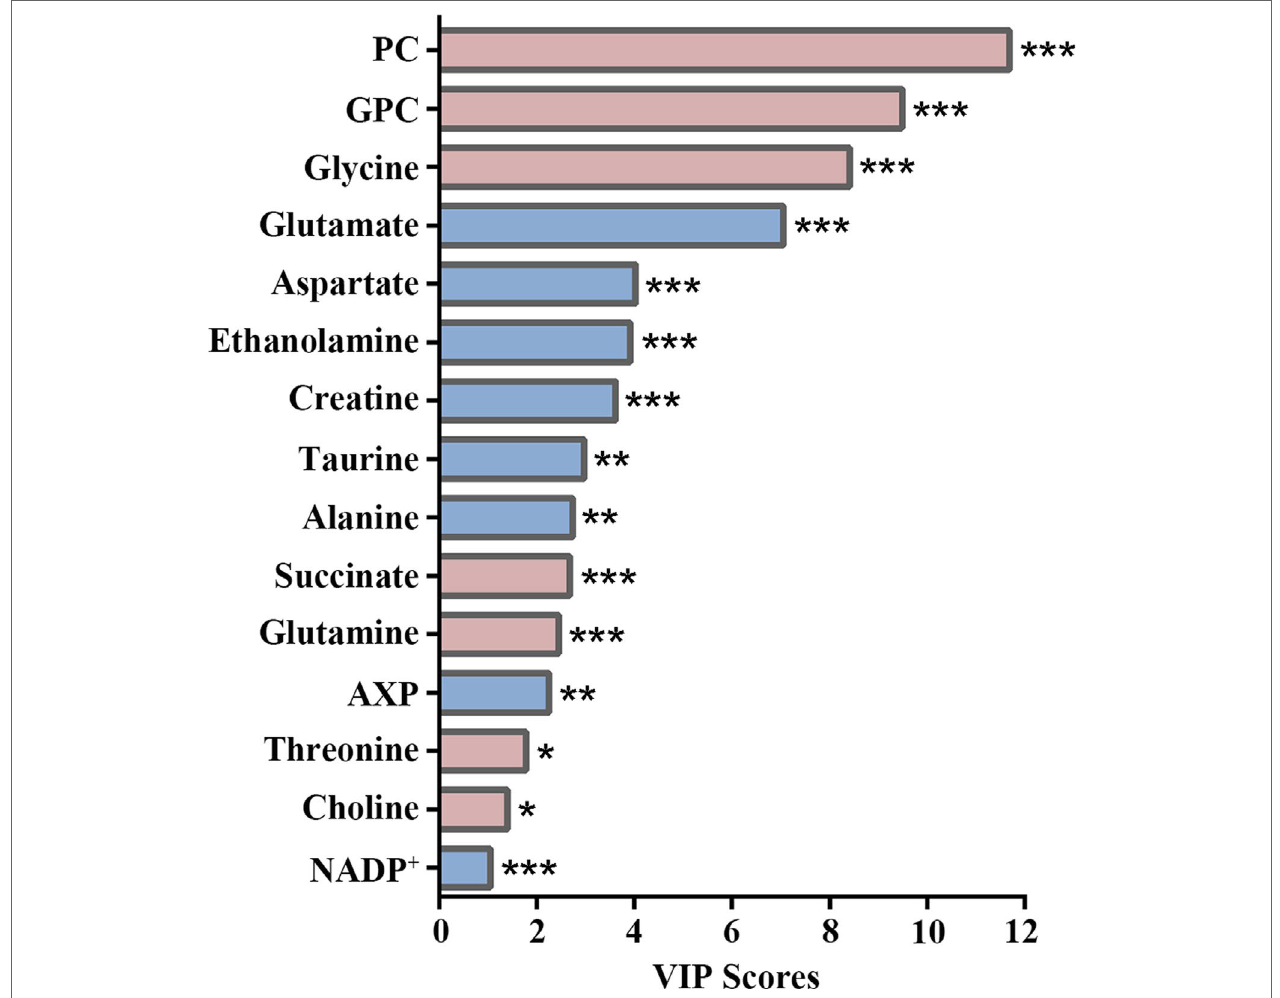
FIGURE 5 | VIP score-rank plot of characteristic metabolites significantly responsible for distinguishing the metabolic profiles between control and ox-LDL groups. Red and blue bars denote the metabolites with increased and decreased levels in the ox-LDL group compared with those in the control group, respectively. Statistical significances: * p < 0.05; ** p < 0.01; *** p <